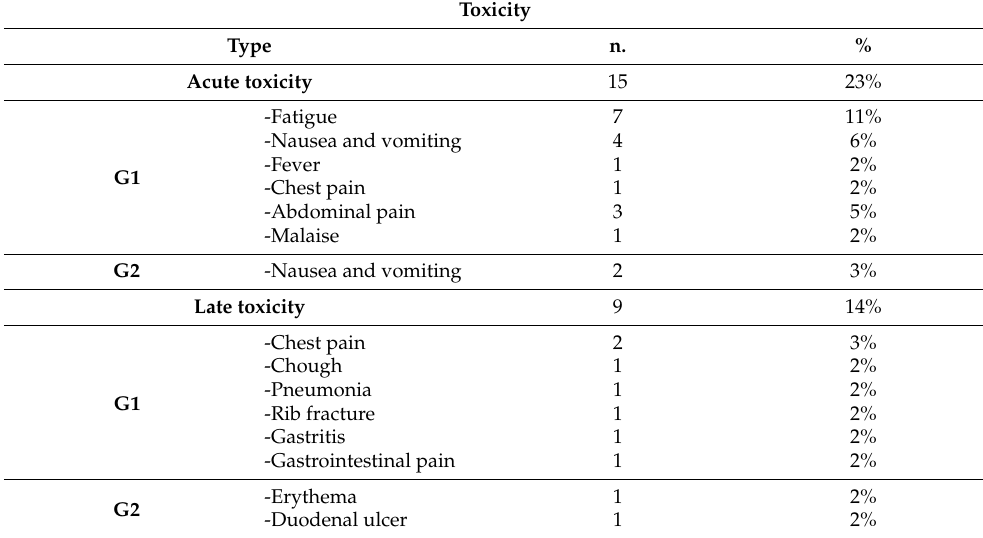
Table 5. Acute and late